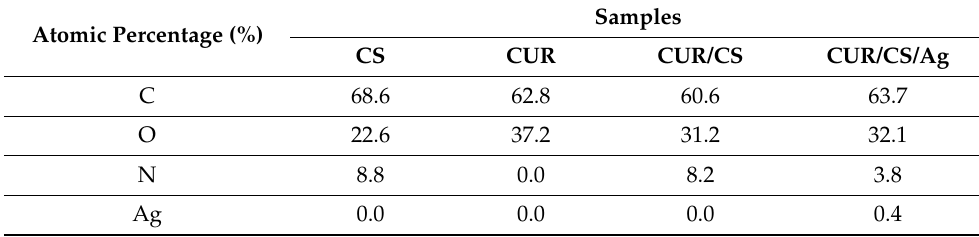
Table 2. Atomic percentages (%) obtained from the XPS surface analyses.